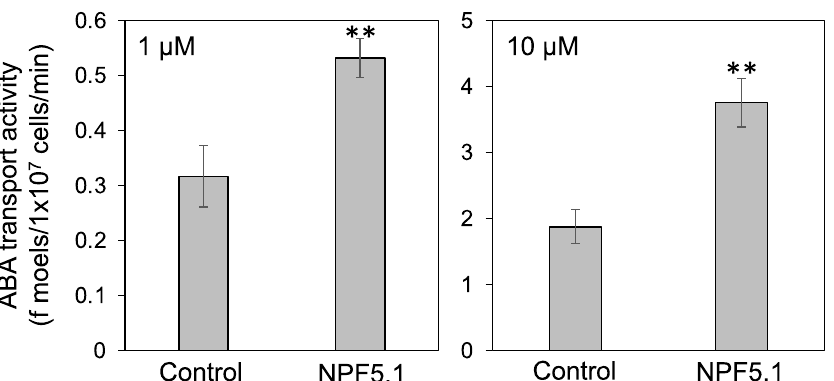
Figure 5. ABA transport activity of NPF5.1. The amounts of ABA (f moels/1 × 10 7 cells/min) taken into yeast cells expressing NPF5.1 or control cells containing an empty vector were determined when the substrate concentration was 1 or 10 µ M. Results are presented as mean ± SD of three biological replicates. ** Significantly different compared with the values in the control cells ( p < 0.001) by Student’s t -test.